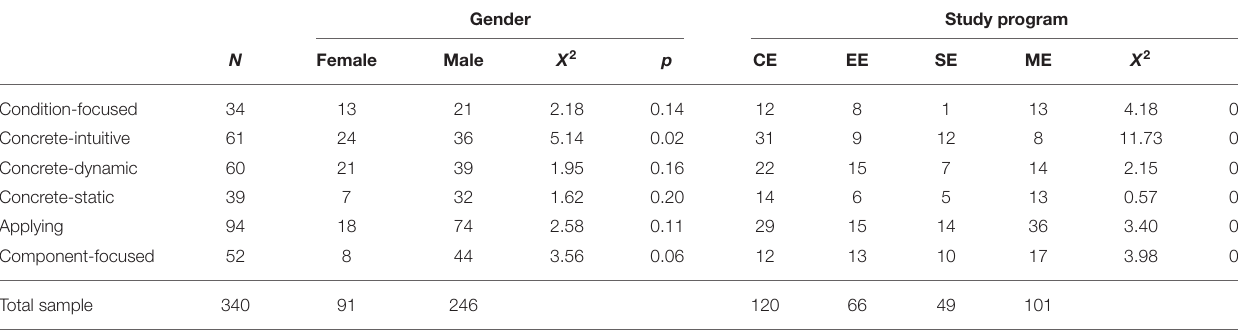
TABLE 4 | Profile size, gender and study program distribution for each ontological profile.